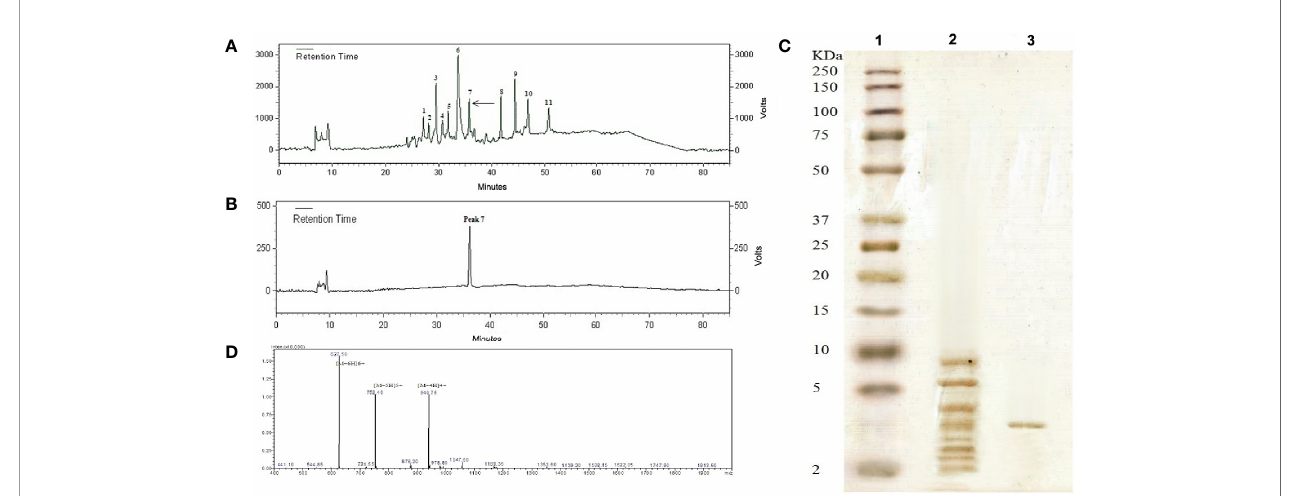
FIGURE 1 | (A) Peptide RP-HPLC puri fi cation from Carum carvi seeds. The arrow shows the active peak 7. (B) The chromatogram obtained after the re- chromatography process to purify the active peak 7. (C) Tricine – SDS-PAGE pro fi le stained with silver (1) molecular weight markers (2 – 250 kDa), (2) the extracted peptide passing through an ultra-membrane with the cutoff of 10 kDa, and (3) the RP-HPLC column puri fi ed peak 7. (D) ESI- mass spectrum of puri fi ed antifungal peptide. Multiple charged molecular ions are